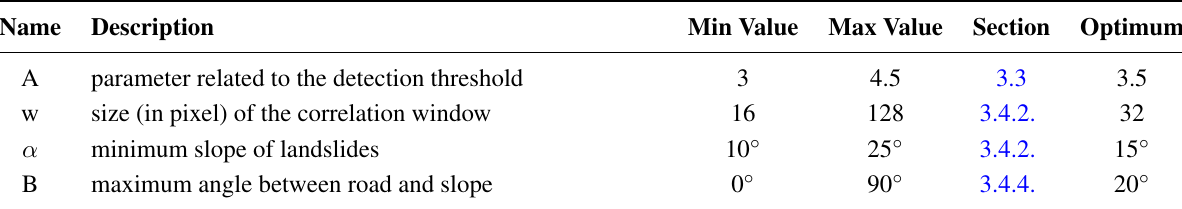
Table 2. Definition and values of the method